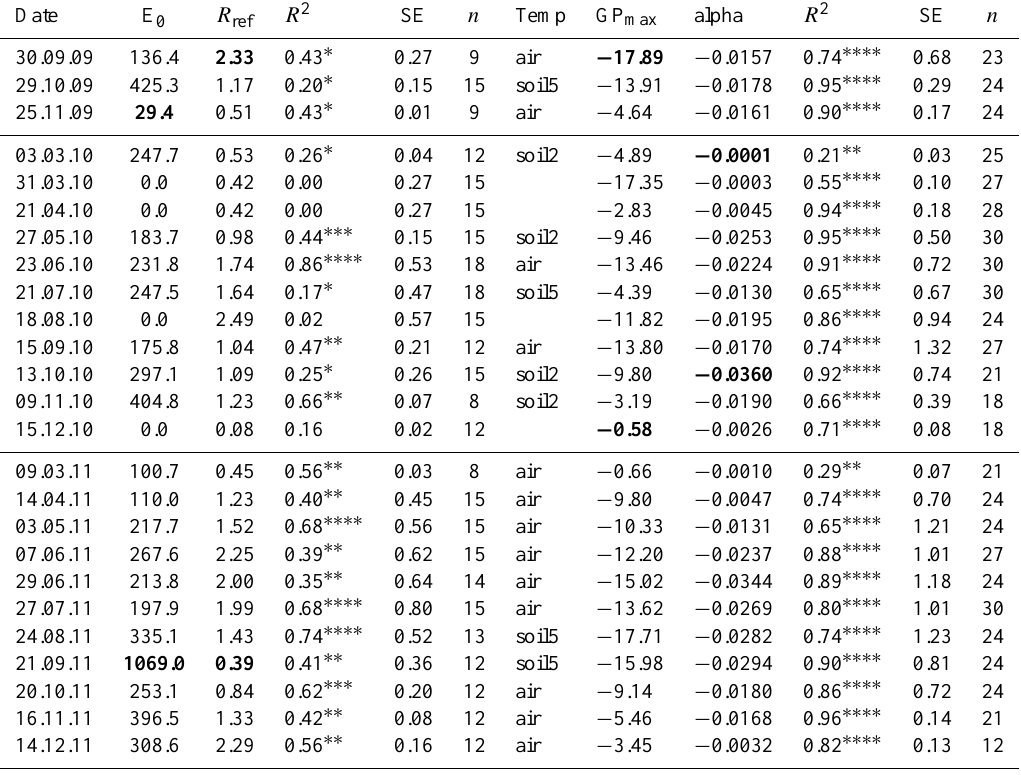
Table 5. Parameters for the R eco and NEE models of “ Sphagnum ”; E 0 : activation energy such as parameter [K]; R ref : respiration at the reference temperature [µmolCO 2 -Cm − 2 s − 1 ]; temp: best fit temperature for R eco model. GP max : maximum rate of carbon fixation at PAR (Pearson) between modelled and measured values. SE: standard error of the model [µmolCO 2 -Cm − 2 s − 1 ]; n : number of samples. Max. and min. values are printed in bold. Eventually measurement campaigns were pooled